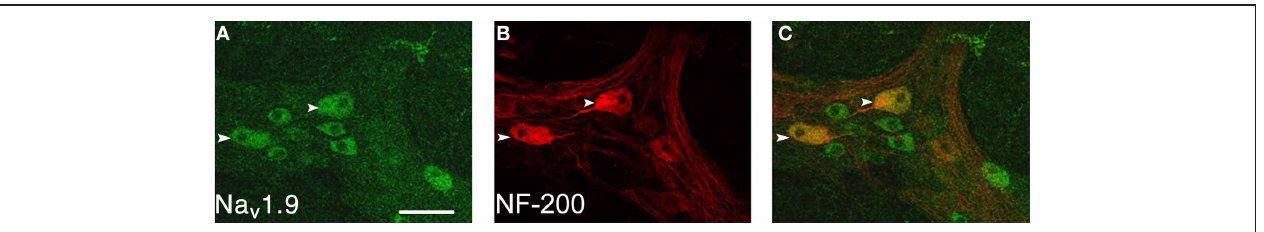
FIGURE 1 | Localization of Na v 1.9 immunoreactivity in the myenteric plexus of the mouse colon. Na v 1.9-like immunoreactivity, detected with L-23 AB (A) , is located in large neurons (arrowheads)